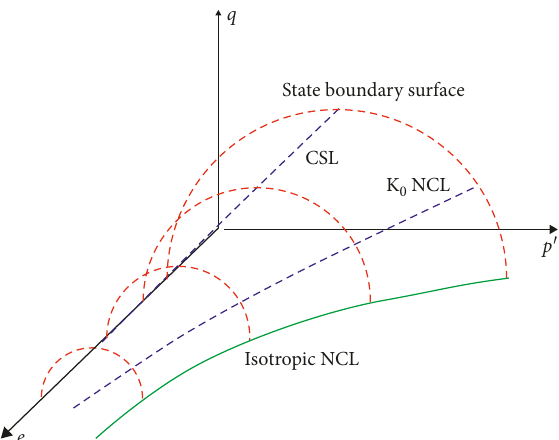
Figure 4: Illustration of state boundary surface in the hypoplastic